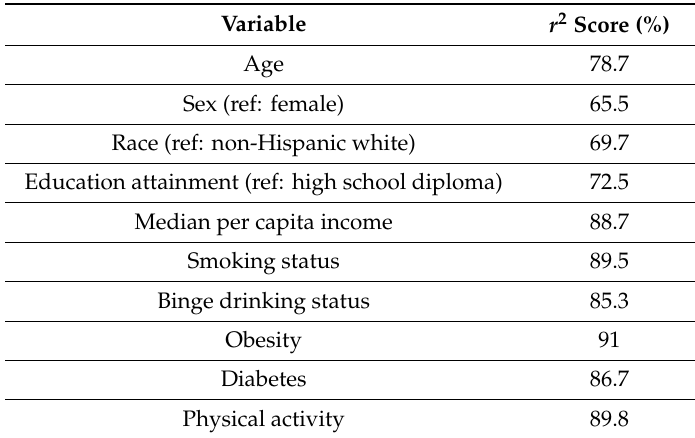
Table 2. r 2 scores of the features extracted from the satellite images to socio-demographic and health population-level measures linked to